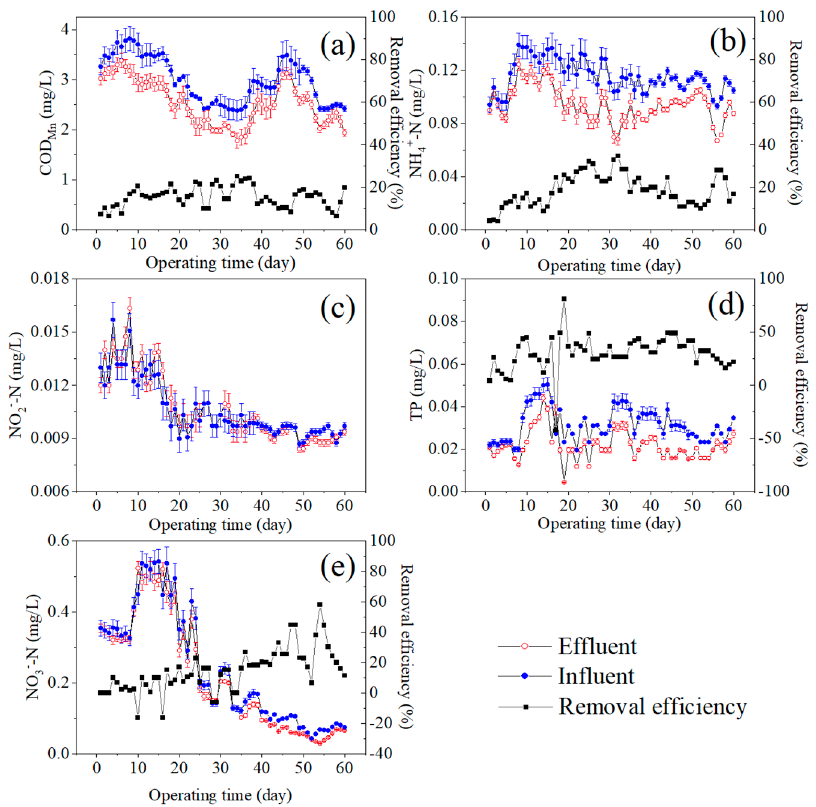
Figure 5. The pretreatment results of micro-polluted water in the pilot-scale phototrophic biofilms: ( a ) COD Mn , ( b ) NH 4+ -N, ( c ) NO 2 − _ N, ( d ) TP and ( e ) NO 3 − _ N.